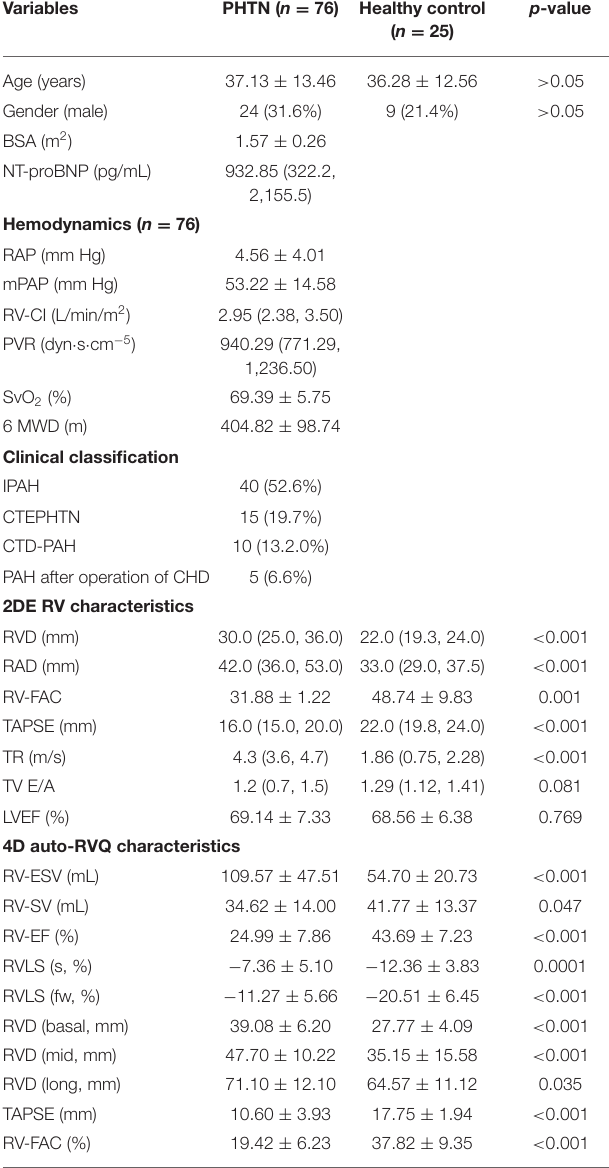
TABLE 1 | Clinical, 2DE, and 4D auto-RVQ characteristics of 76 patients with pulmonary arterial hypertension.